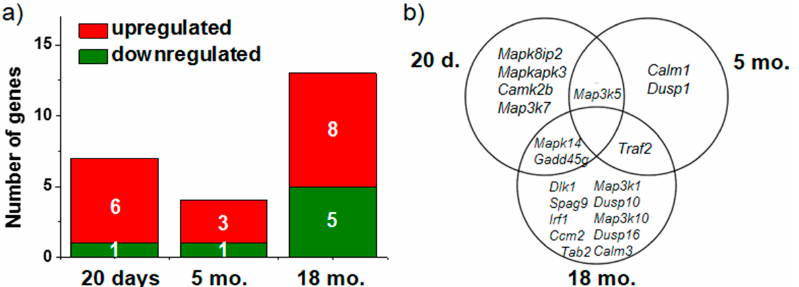
Figure 1. The impact of age on the number of differentially expressed genes (DEGs) involved in the p38 mitogen-activated protein kinase signaling pathway (MAPKsp) in OXYS rats ( a ). The Venn diagram shows overlapping sets of DEGs among 20-day-old and 5- and 18-month-old OXYS rats compared to age-matched Wistar rats ( b ). 3.2. Age-related Alteration in p38 MAPK and Phospho- (p-)p38 MAPK Content in the Hippocampus of Wistar and OXYS Rats The western blotting revealed that the level of the p38 MAPK protein in the detergent-soluble fraction was dependent on age (F 1,24 = 9.1, p < 0.01) and was the lowest at the age of 20 days in the hippocampus of both Wistar and OXYS rats (Figure 2a,b). The level of p38 MAPK in the detergent- insoluble fraction had no differences between the two rat strains and did not change with age (Figure 2a,b).